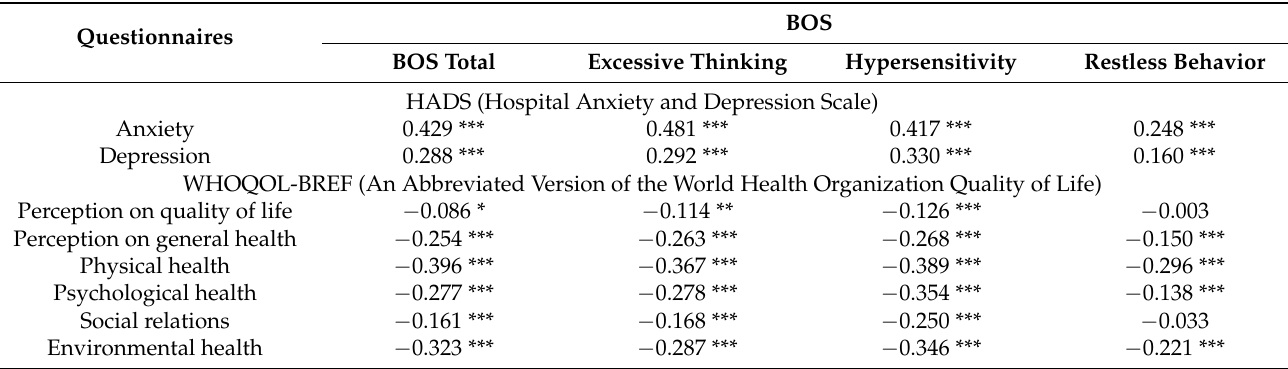
Table 7. Criterion validity of the BOS ( n =